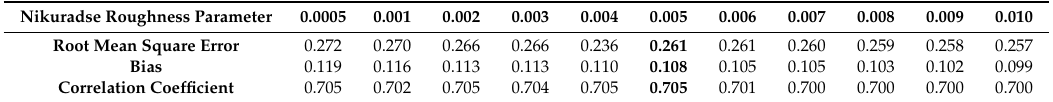
Table 2. The results of the Baltic Sea’s near shore wave model calibration. Nikuradse Roughness Parameter